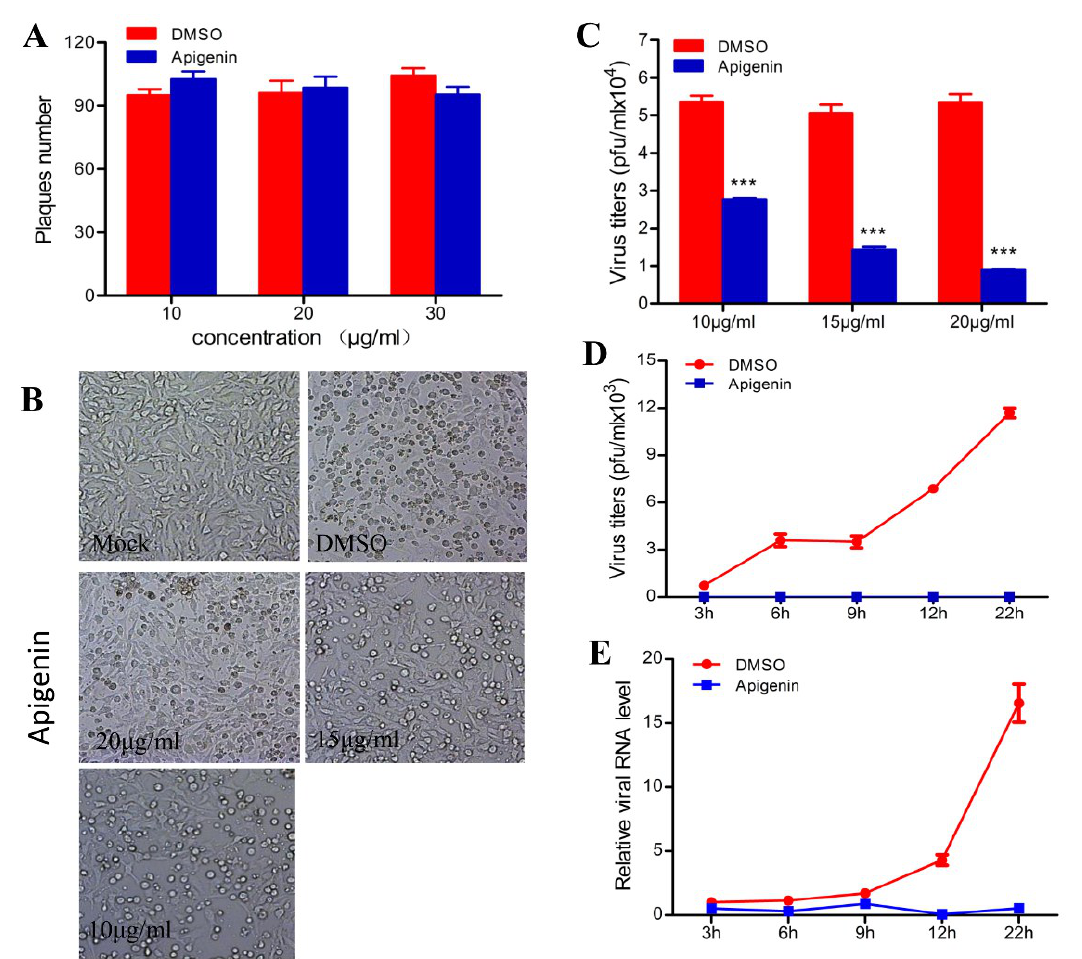
Figure 3. Apigenin has an intracellular antiviral activity. ( A ) Direct virucidal activity of apigenin against FMDV. Moreover, 10 5 PFU FMDV particles were incubated with apigenin